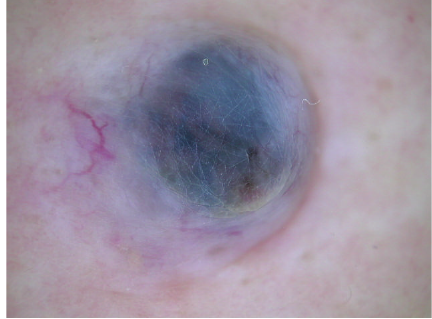
Figure 2: Dermatoscopic examination showed a homogenous blue/black area and arborizing telangiectasia.